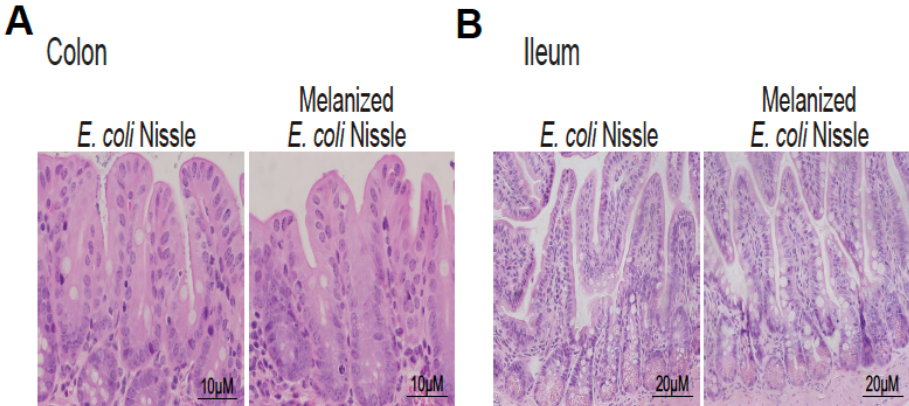
Figure 3. The morphology of colon and ileum did not change in the CD-1 mice one-gavaged with probiotic E. coli Nissle or melanized E. coli Nissle in H&E staining. ( A,B ) Representative H&E images were from a single experiment and were representative of 6 mice per group.